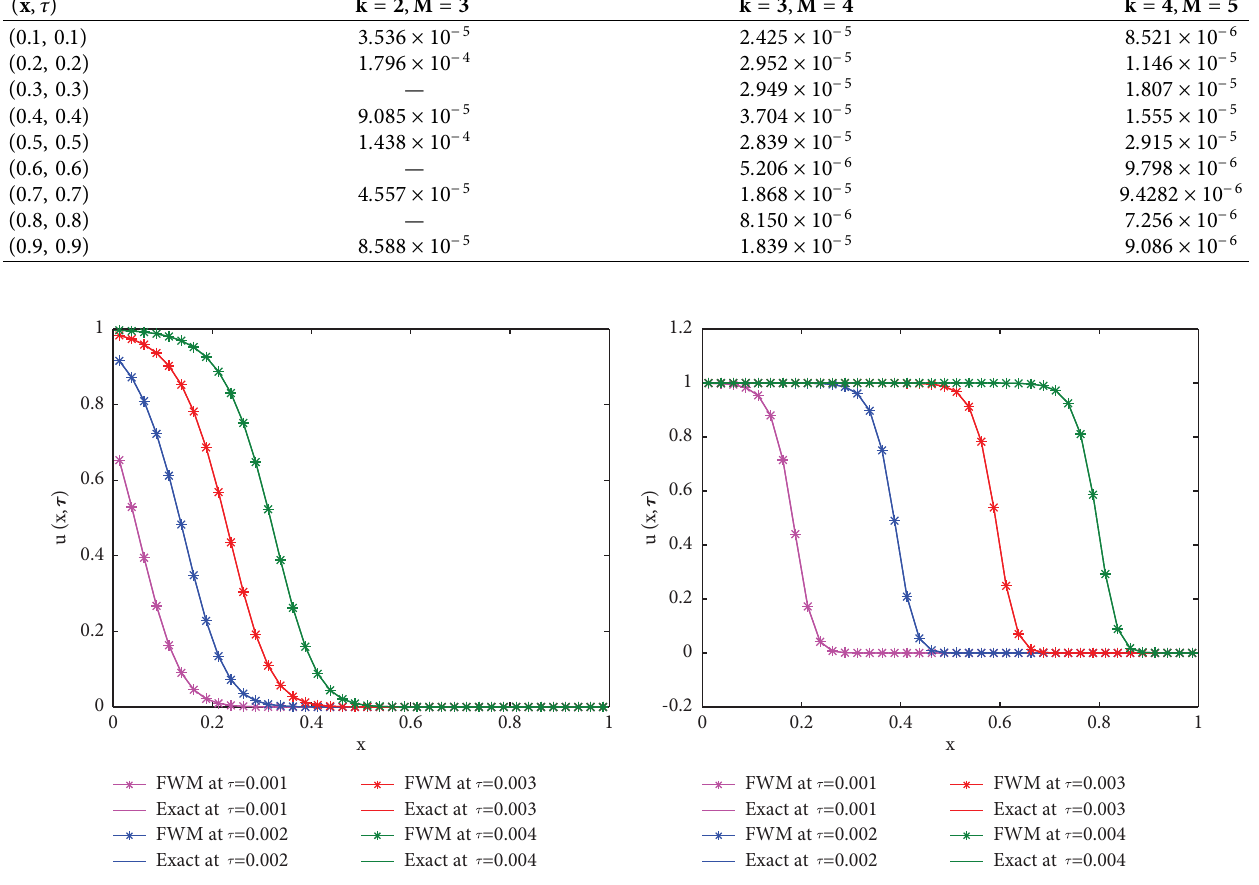
� 2000. (b) Comparison of approximate solution and exact 2